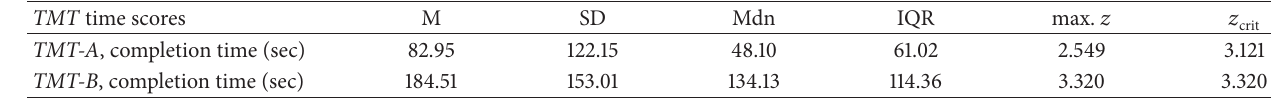
) over various TMT time crit